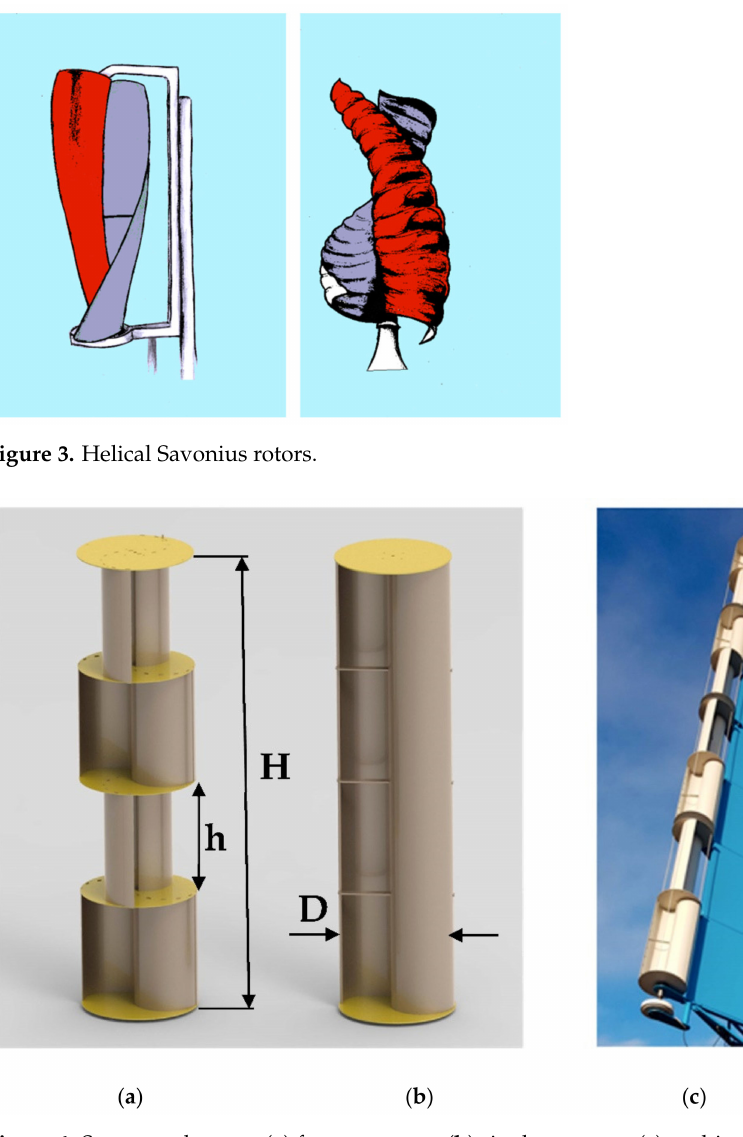
Figure 4. Segmented rotors; ( a ) four segments; ( b ) single segment; ( c ) multi rotor test turbine; height H and diameter D are the same for both ( a , b )